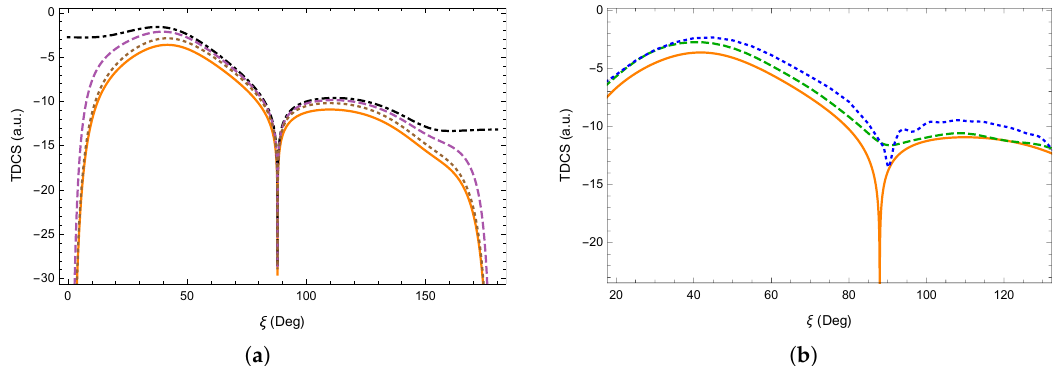
Figure 3. Triply differential cross section (TDCS) on a log (ln) scale versus the polar angle ξ for electron-impact ionization of hydrogen at 76.4541 eV. ( a ) Comparison of the CB1 TDCS (dot-dashed black line), the modified CB1 TDCS with r 3 ave = 0 (solid orange line), the modified CB1 TDCS with r 3 ave = 1/ k 3 (dashed purple line) and the modified CB1 TDCS with r 3 ave given by Equation (4) (dotted brown line). ( b ) Comparison of the modified CB1 TDCS with r 3 ave = 0 (solid orange line) with an incident energy of 76.4541 eV, the 3DW TDCS (dotted blue line) for an incident energy of 76.46 eV, and the TDCC TDCS (dashed green line) for an incident energy of 76.45